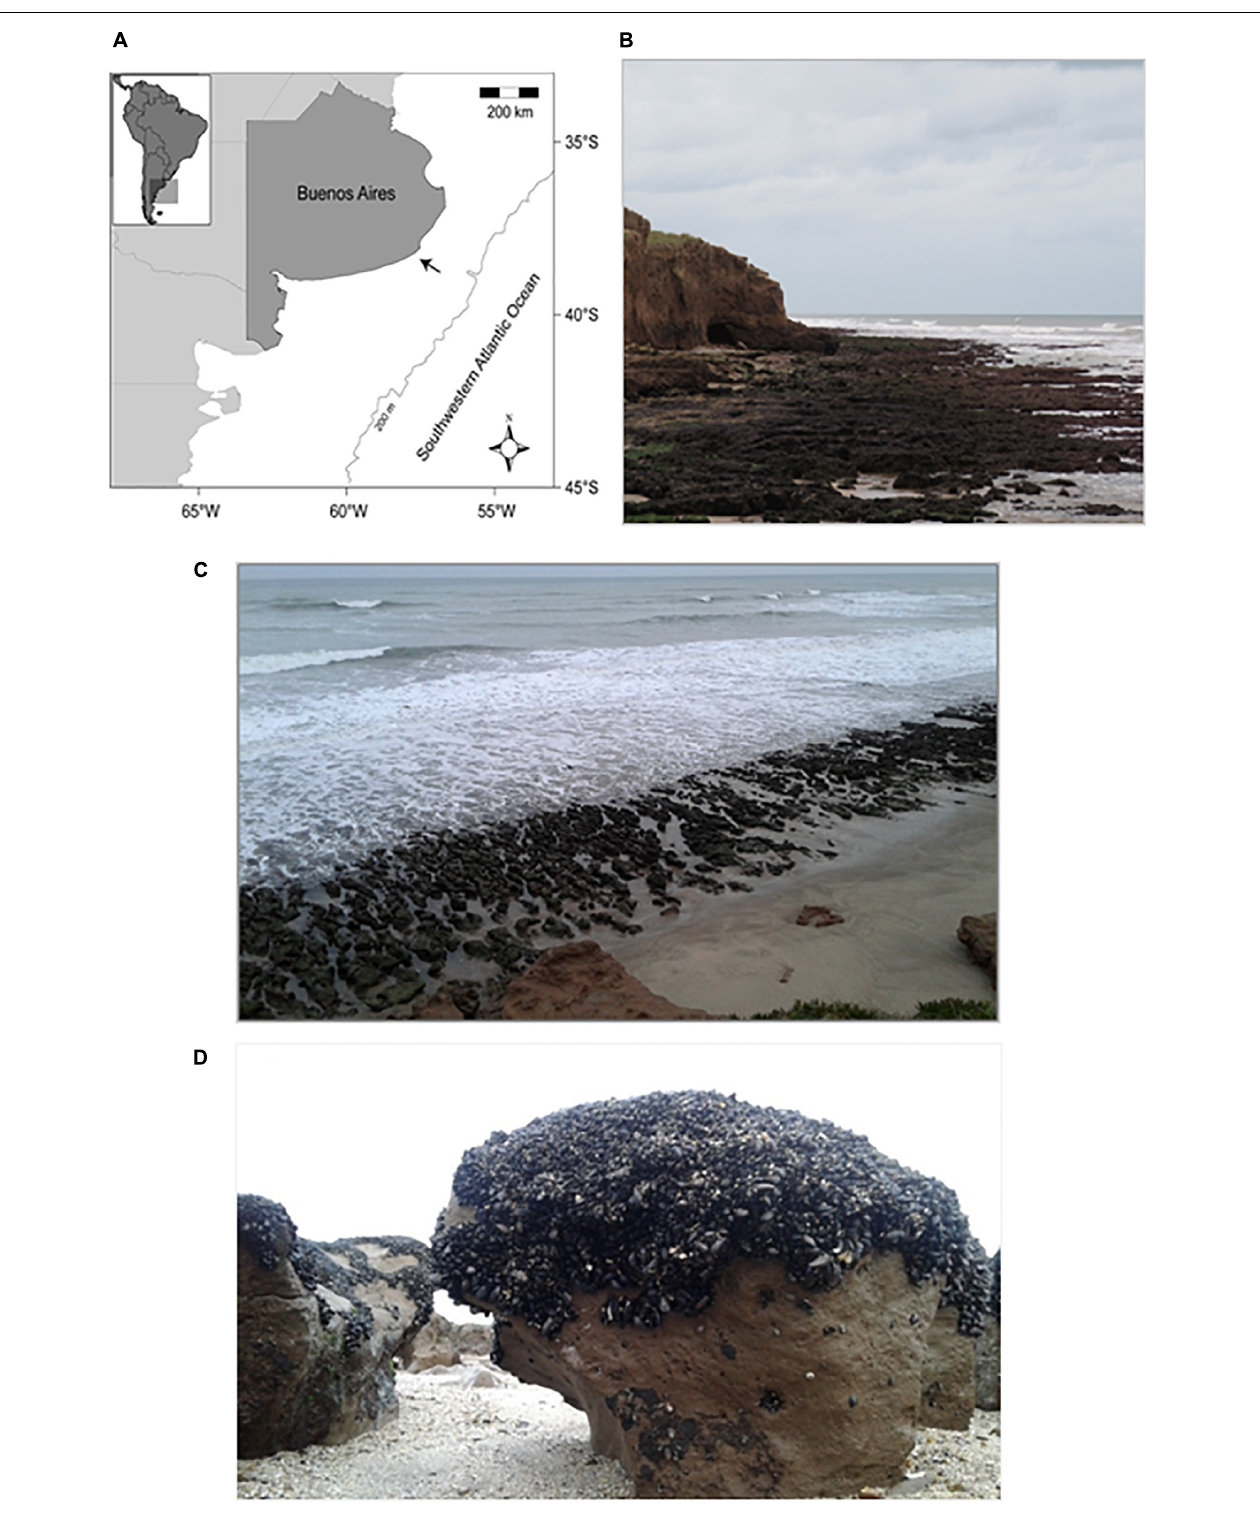
FIGURE 1 | (A) Location of the study site on the coast of Buenos Aires province, Argentina (indicated by an arrow). (B) Panoramic view of a studied platform and its backing cohesive cliff (8–12 m high) during a very low tide. (C) Clifftop view of the study site at low tide. The platform is incised by rills and fragmented into benches of varying sizes (typically < 4 m 2 ). (D) Close-up view of a bench showing mussel cover on the top surface and the upper portion of the sides. Note the sand and gravel accumulation at the bottom of the rill. The approximate height of this bench above the sand/gravel level is 50 cm.